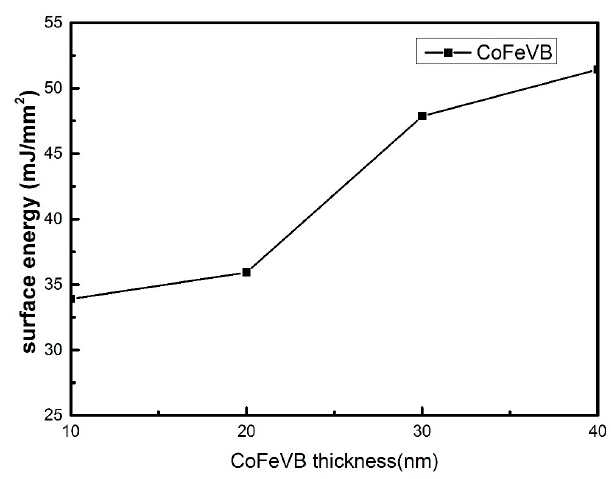
Figure 9. Surface energy results for the Co 40 Fe 40 V 10 B 10 films.